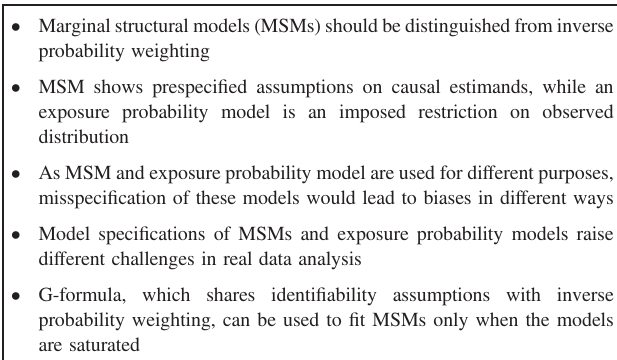
Box. Key messages for clear understanding of marginal struc-